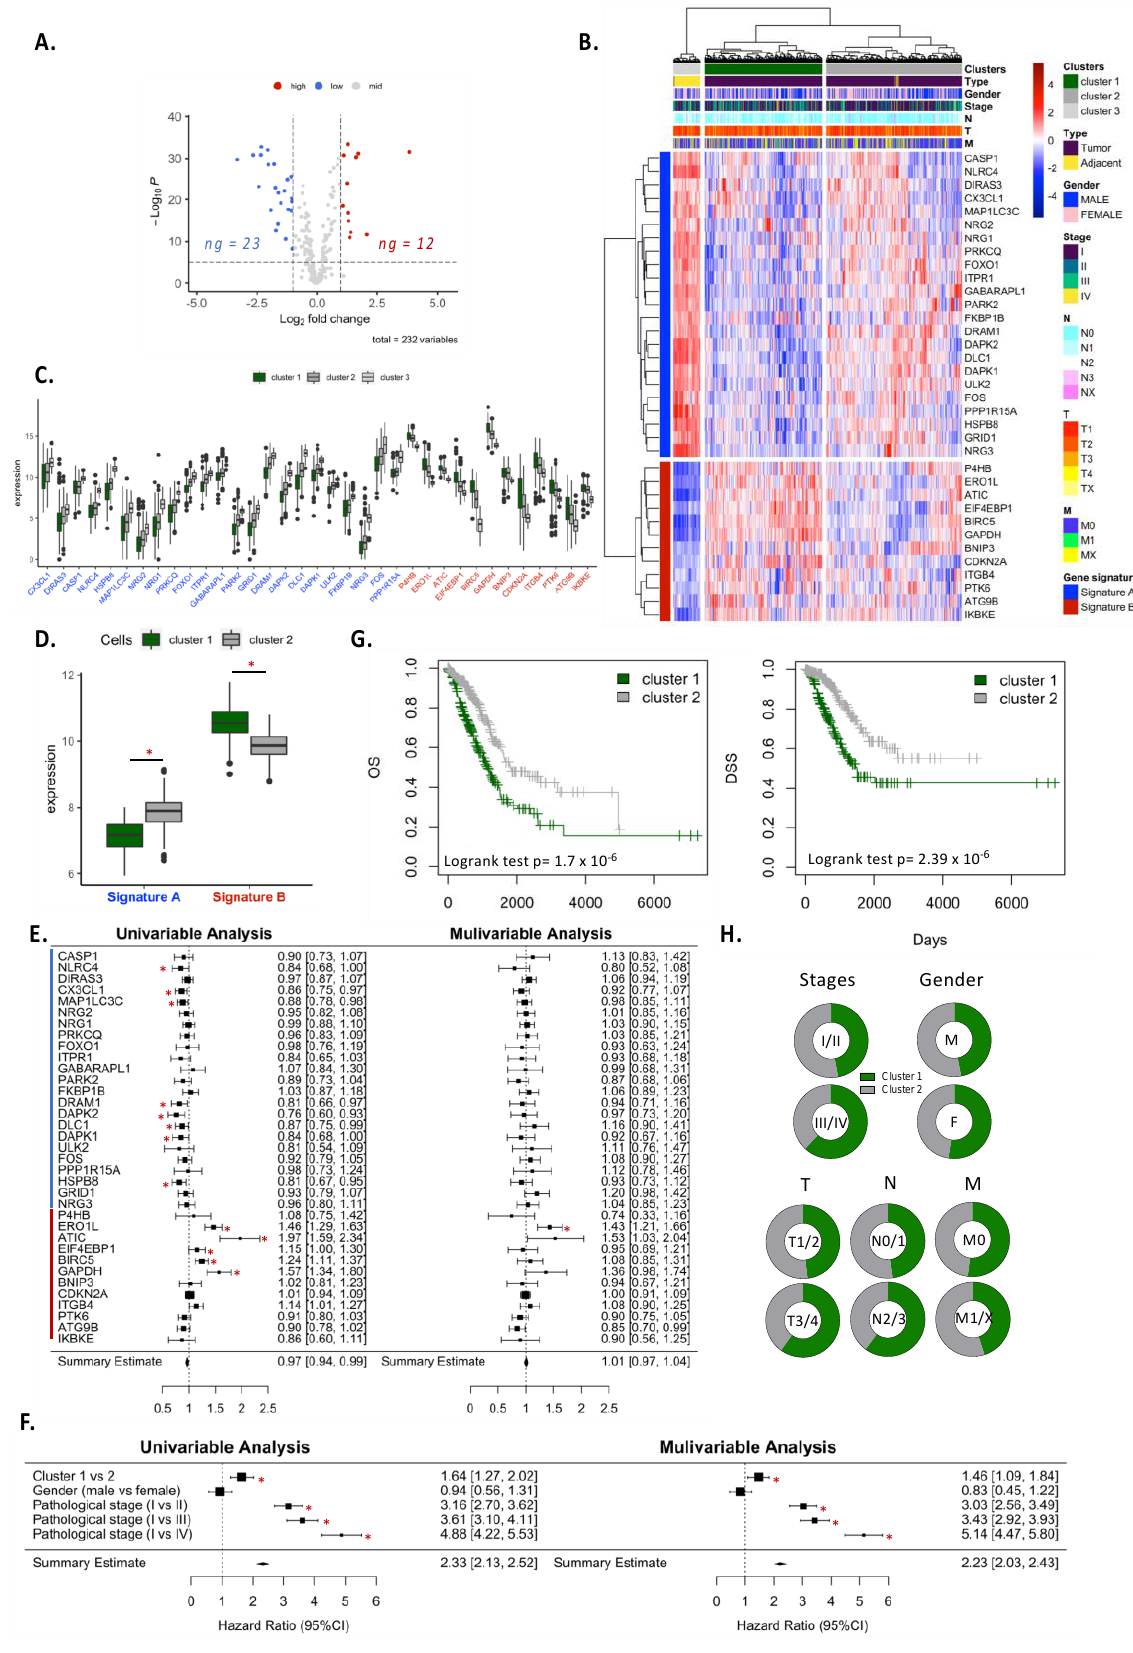
Figure 2. Autophagy genes screening and cluster analysis in lung adenocarcinoma. ( A ) Differential expression analysis for the human autophagy database ( n = 232 genes) of TCGA-LUAD